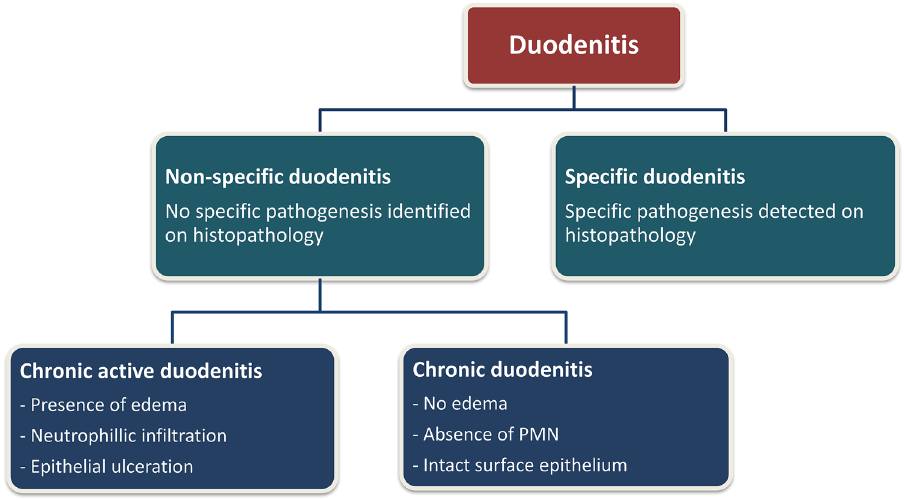
Figure 1. Operational classification of duodenitis based on pathogenesis and cellular activity. Specific duodenitis Presence of a disease process such as Crohn’s disease, sarcoidosis, etc.; PMN Polymorphonuclear leukocytes.